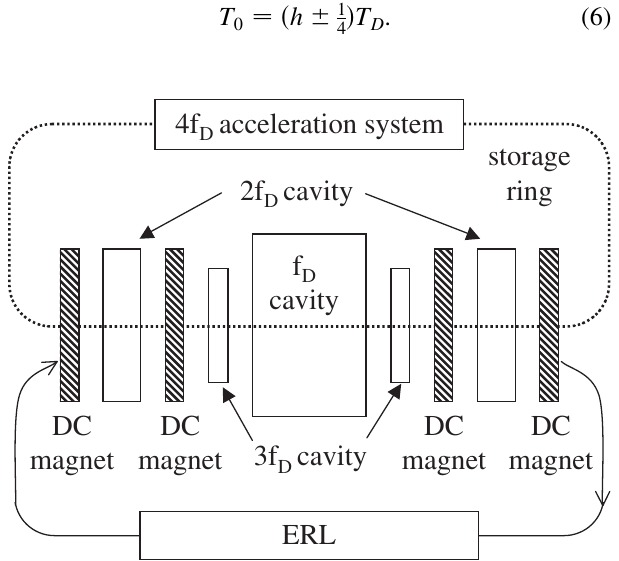
FIG. 5. Possible configuration of four-turn system. System consists of deflection cavities with frequency f , and DC 3 f D